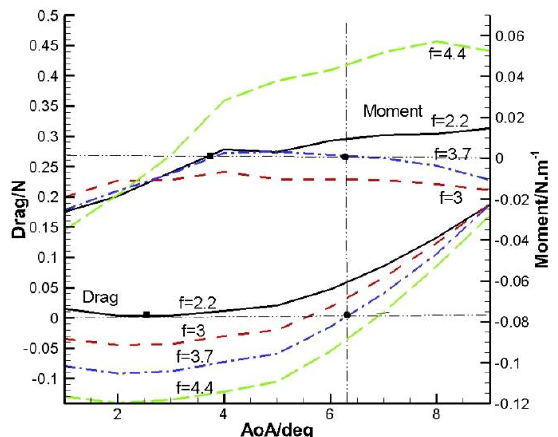
Figure 9. Trim process through adjusting the angle of attack and flapping frequency while keeping the forward-sweep angle at 28 degrees.